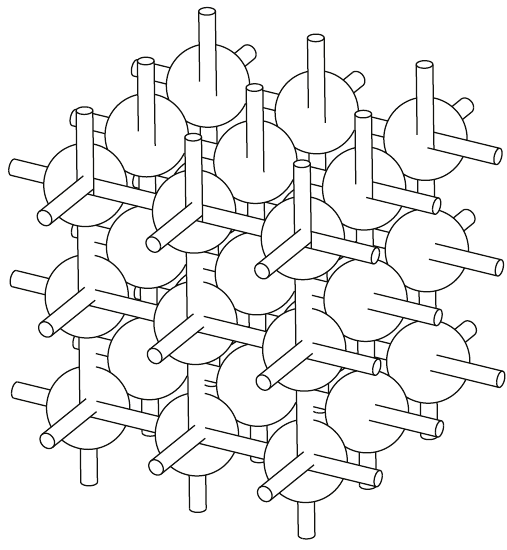
Figure 19: Crosslinked